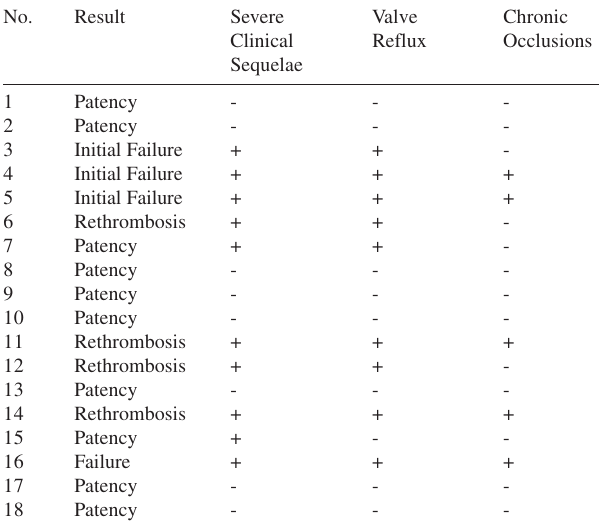
Table 3 - Late clinical and echographic results of thrombolysis therapy